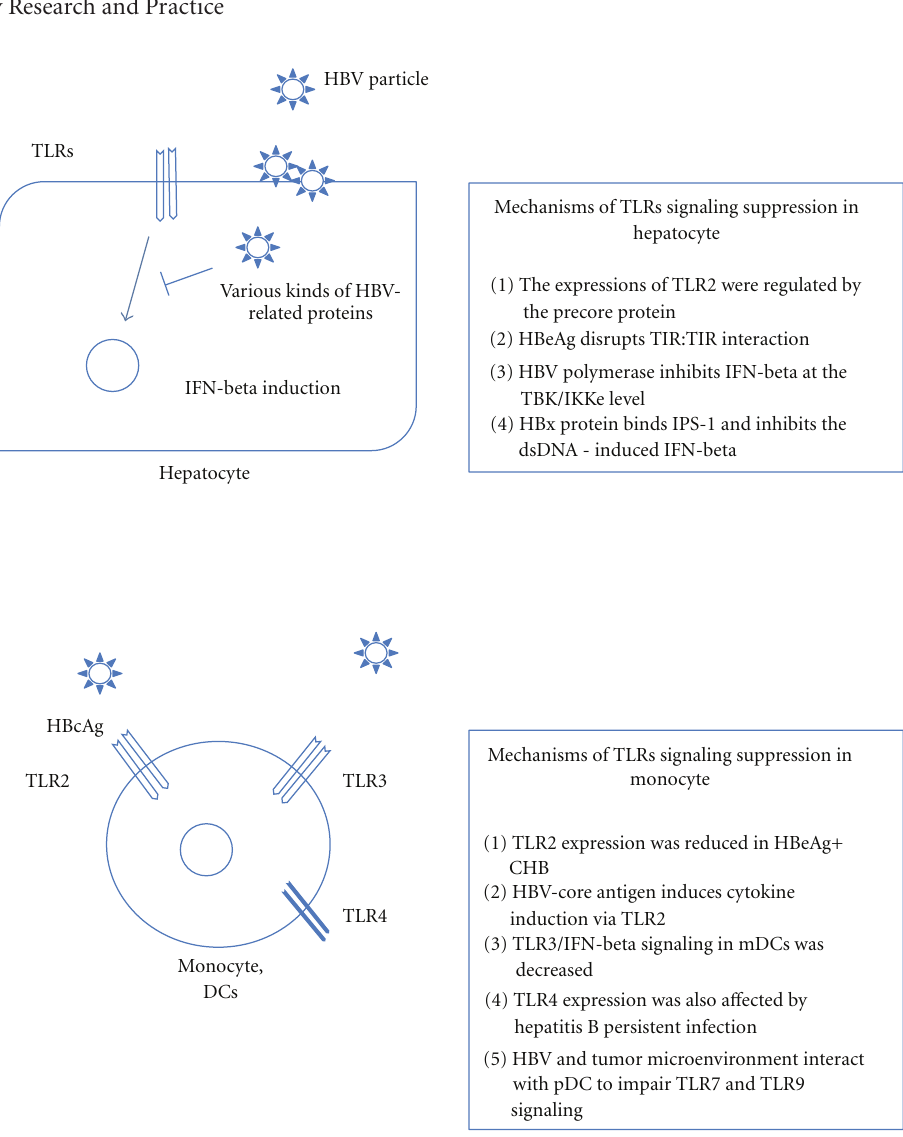
Figure 1: TLRs contribution to Hepatocellular- and monocyte-related immune